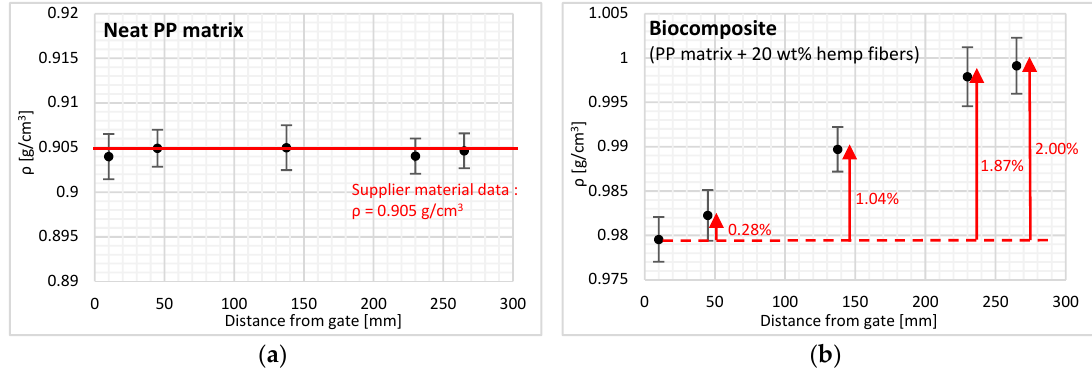
Figure 4. Density along the flow path for the ( a ) neat polypropylene (PP) matrix and ( b ) PP reinforced with hemp fibers. Error bars correspond to plus or minus the standard deviation.